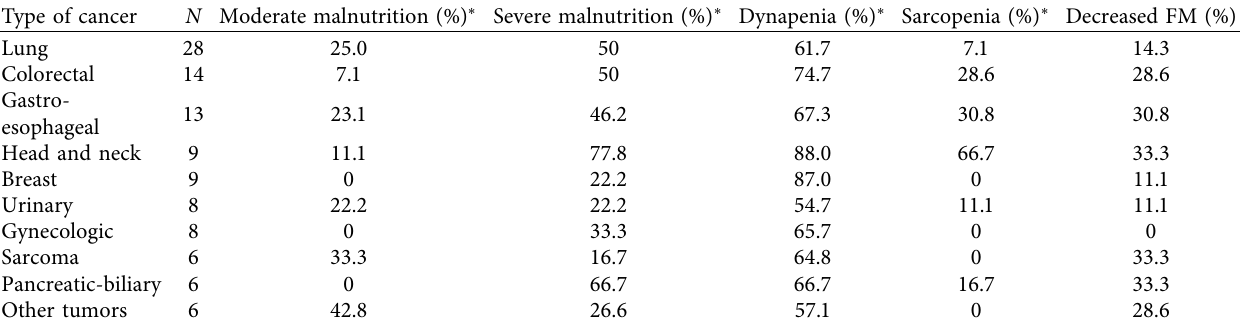
Table 3: Prevalence of moderate malnutrition, severe malnutrition, dynapenia, and sarcopenia by type of tumor. Type of